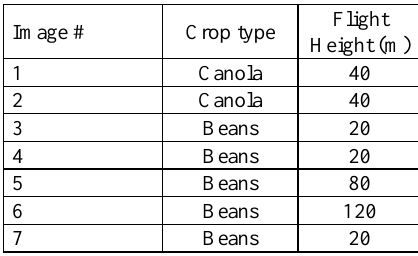
Table 1. List of the used images to evaluate the proposed